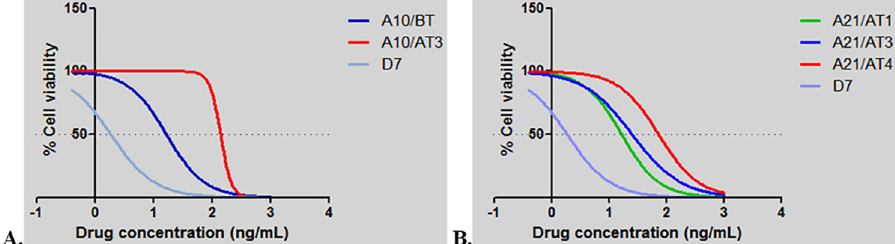
Fig 2. MTT assay of T . annulata infected cell lines obtained from animals A10 (A) and A21 (B) following repeated buparvaquone treatments. Numbers on the x axis (-1, 0, 1, 2, 3 and 4) indicates drug concentrations used to treat cell lines at doses of 0, 0.8, 7, 125, 1000 and 1500 ng/mL, respectively.